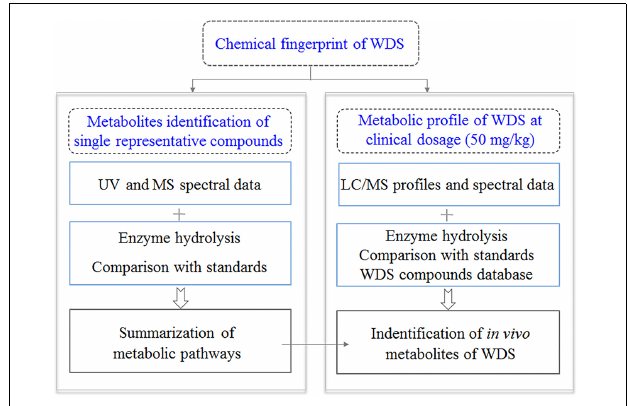
FIGURE 1 | The three-step strategy proposed in the present